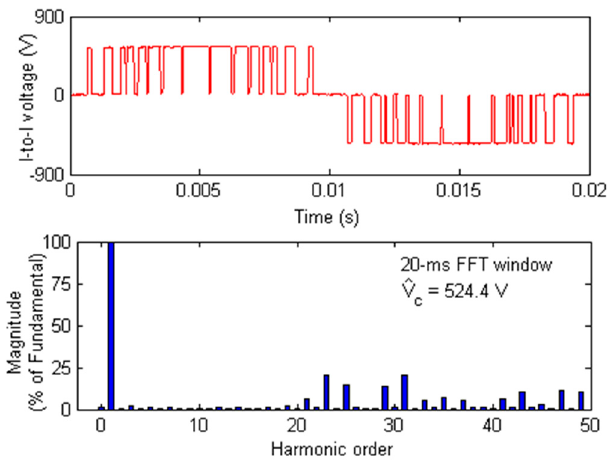
Figure 13. Line ‐ to ‐ line (l ‐ to ‐ l) voltage output of the VSC at the top when V dc = 560 V, and its harmonic spectrum at the bottom.